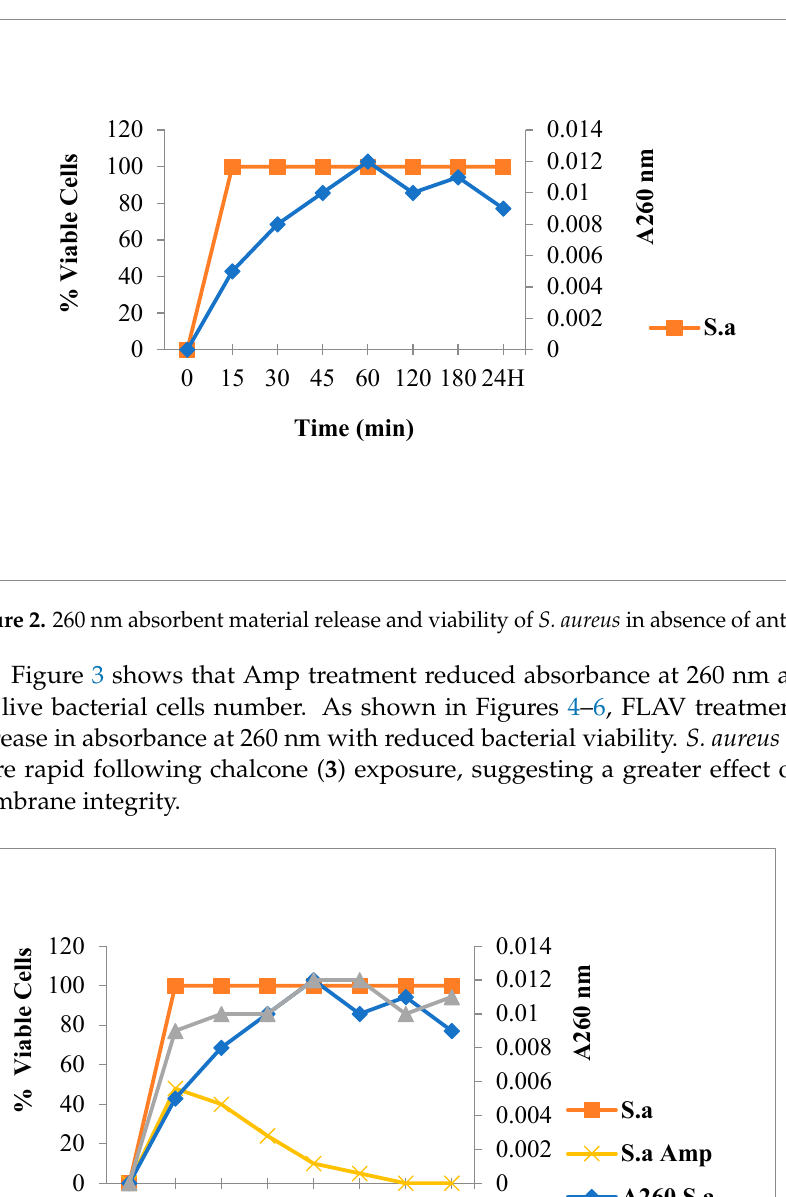
Figure 4. 260 nm absorbent material release and viability of S. aureus following Chalcone 3 treat- ment.